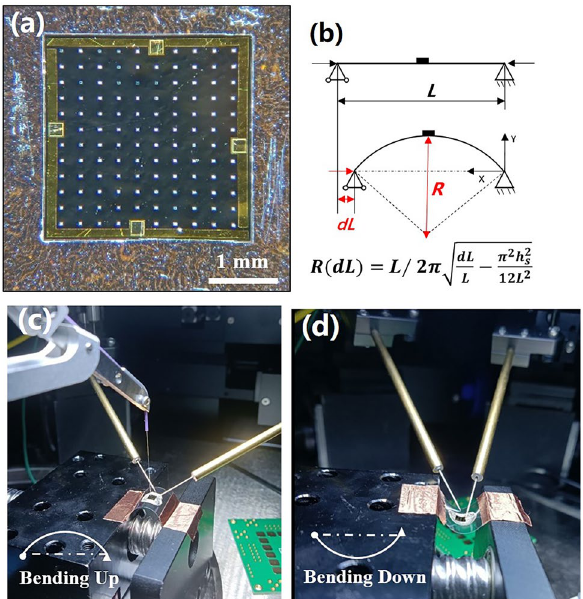
Figure 3. ( a ) Zoom-in views of a fabricated large area (3 × 3 mm 2 ) InGaAs PD on flexible PET substrate. ( b ) Schematic diagram for the measurement principle and the corresponding model. ( c , d ) A schematic diagram of fabricated flexible InGaAs PD under bending up and bending down test, respectively. The bottom left insets provide schematic illustrations of the bending